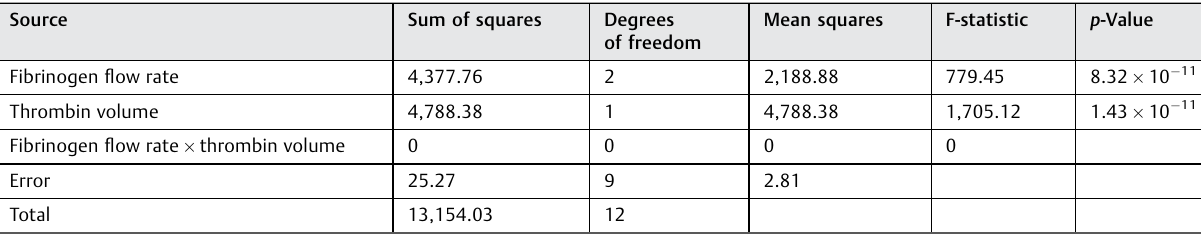
Table 2 Results of two-way ANOVA for unbalanced design Source